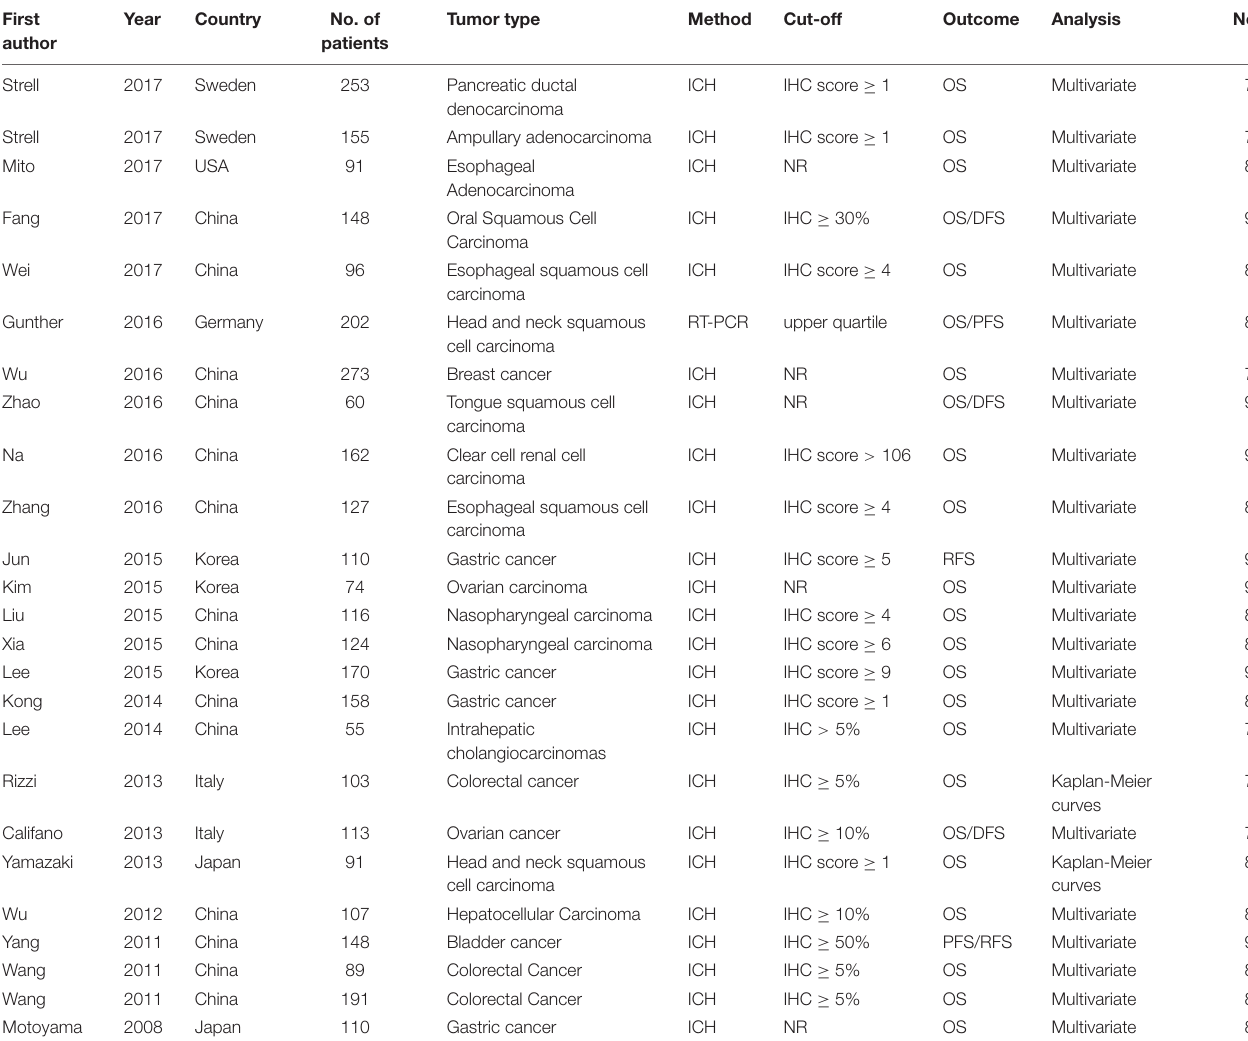
TABLE 1 | Characteristics of eligible studies in this